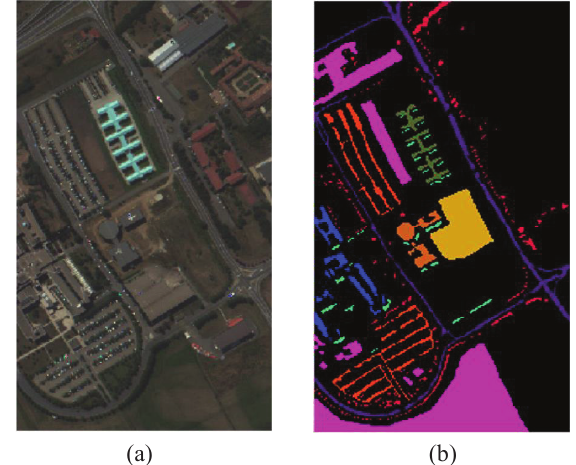
Figure 5. The University of Pavia data set. ( a ) A false color map. ( b ) The ground truth map.